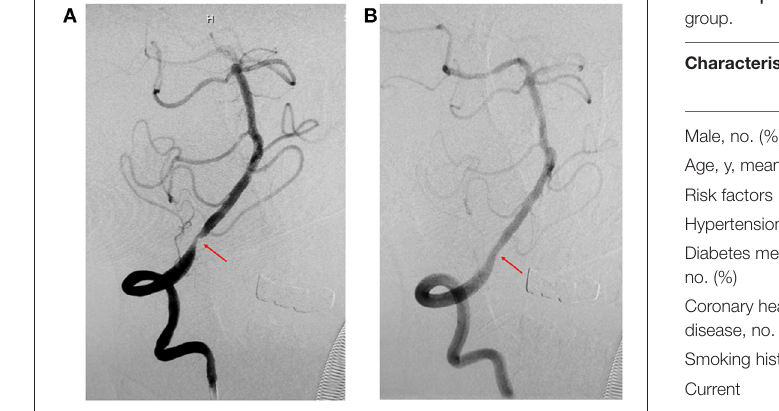
FIGURE 1 | Representative images of cases of V4 before and after stenting (Apollo stent). (A) Digital subtraction angiography (DSA) revealed severe stenosis of the right intracranial vertebral artery (V4) before stenting (red arrow). (B) DSA revealed significant improvement in stenosis of the right intracranial vertebral artery (V4) after stenting (red arrow).